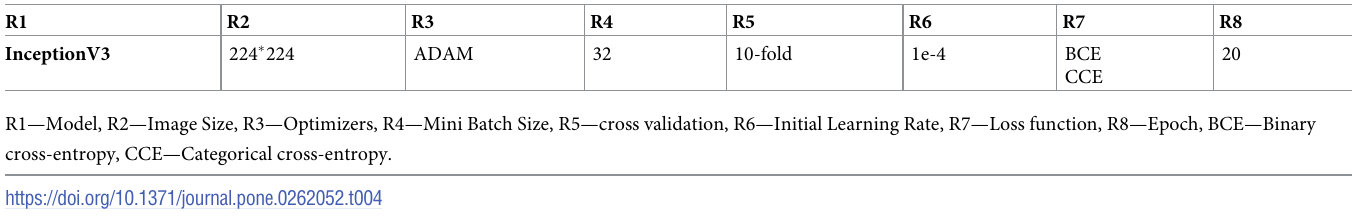
Table 5. Hyper-parameters of the Xception model and preferred weights in this study. R1